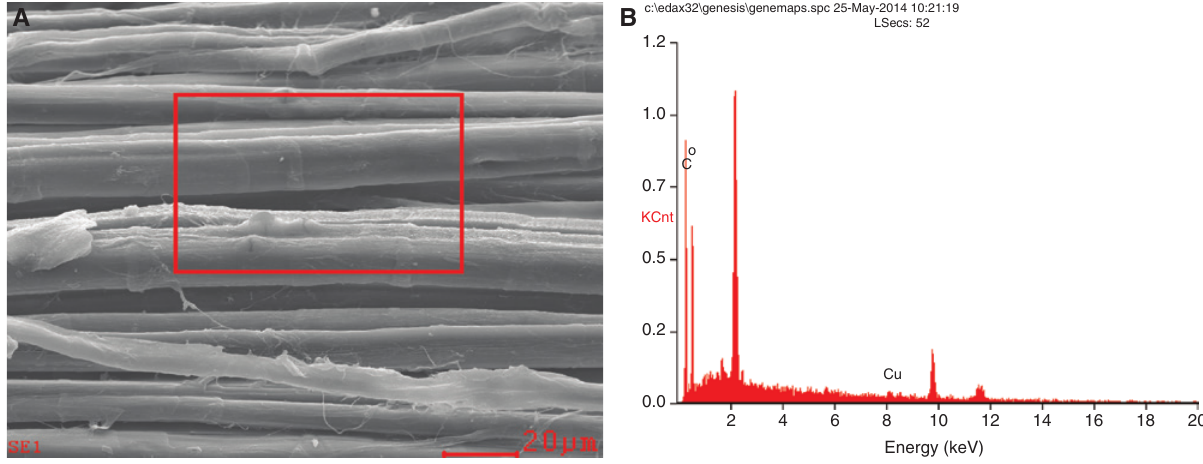
Figure 6: (A) SEM of Cu modified flax fibre and (B) EDS of the selected area shown in Figure 5(A).